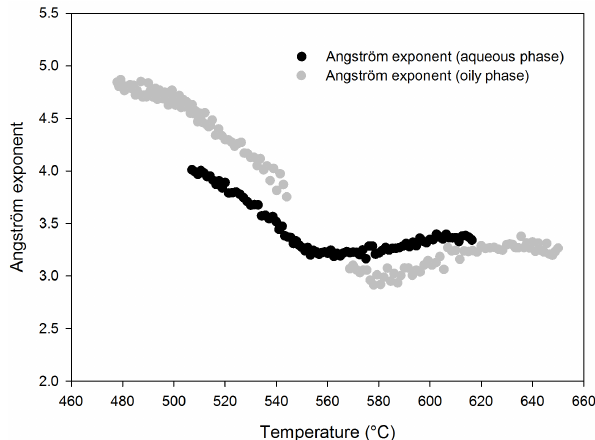
Figure 4. The effect of heat shock (oven temperature) on the Ångström exponent of TB particles generated from the aqueous and from the oily phase of wood